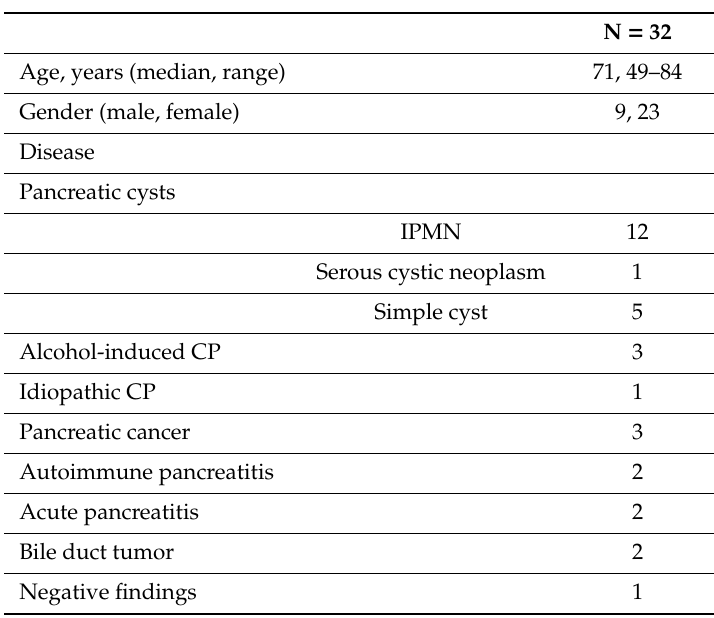
Table 1. Patient